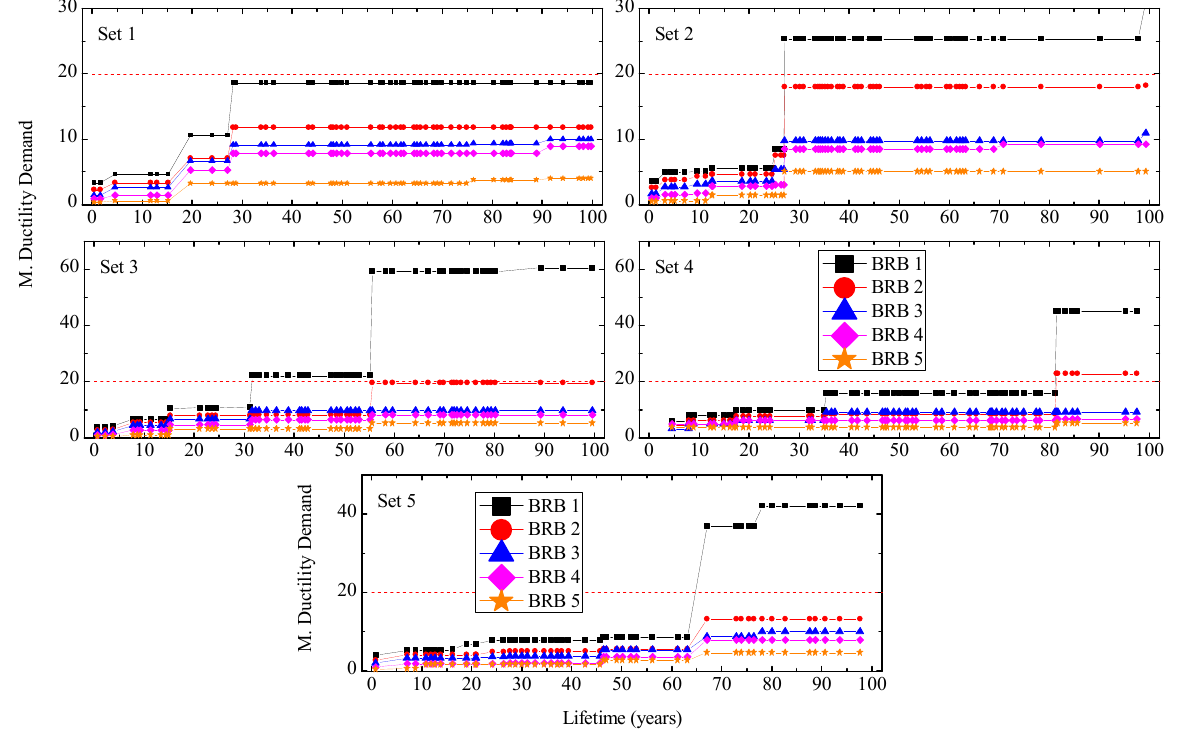
Figure 20. Maximum ductility demand of selected BRBs under multi-hazard scenarios.